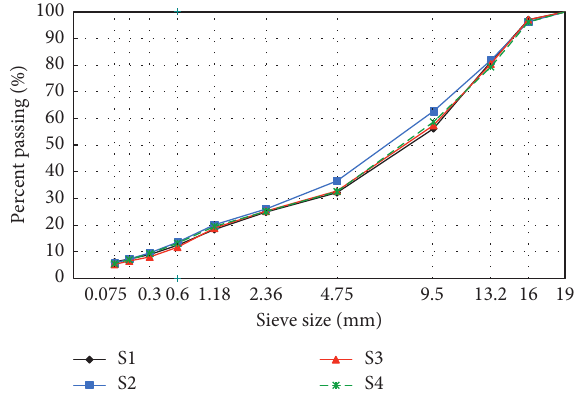
Figure 2: Design gradation curve. Table 4: Technical specifications of the asphalt mixture.